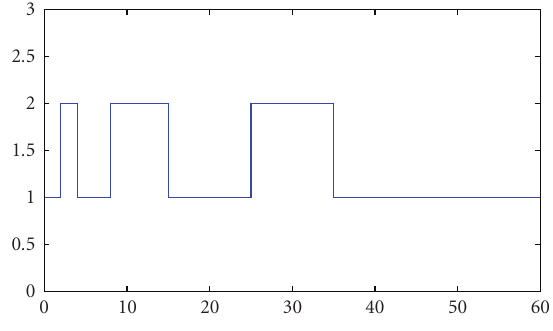
Figure 2: Randomly generated switching signal.